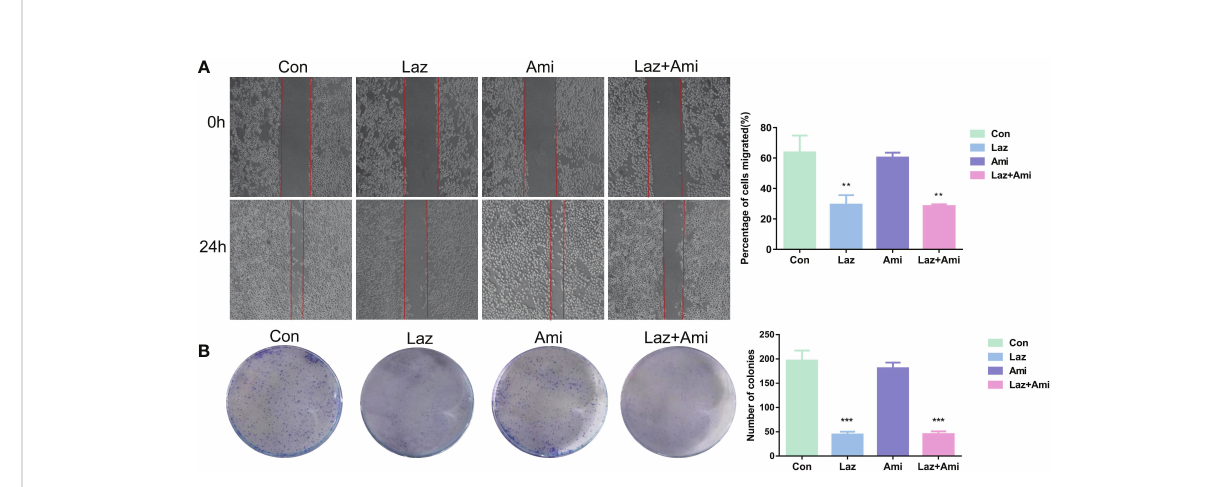
FIGURE 6 The effect of lazertinib and amivantamab on migration and proliferation of patient ’ s lung adenocarcinoma cells. (A) Scratch assay shows lazertinib inhibits migration ability of lung adenocarcinoma cells better than amivantamab; (B) Colony-forming unit assays shows lazertinib inhibits lung adenocarcinoma cell proliferation ability more than amivantamab. *p < 01, ***p <